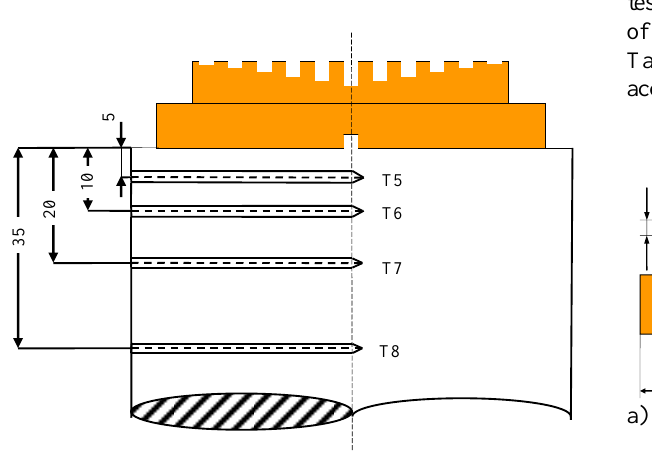
Fig. 3. Arrangement of thermocouples.